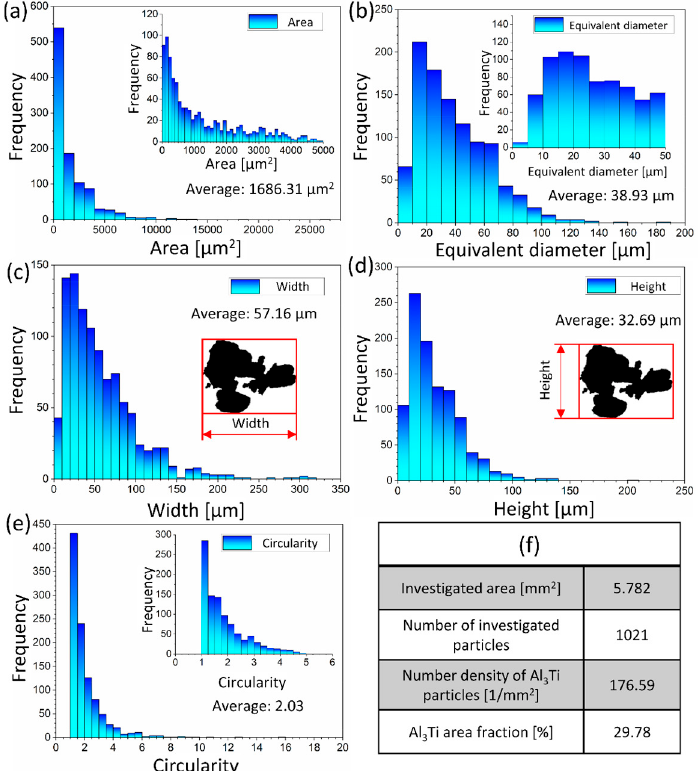
Figure A3. ( a – f ) Results of the image analysis of Al3Ti particles in the Al-10%Ti master alloy.